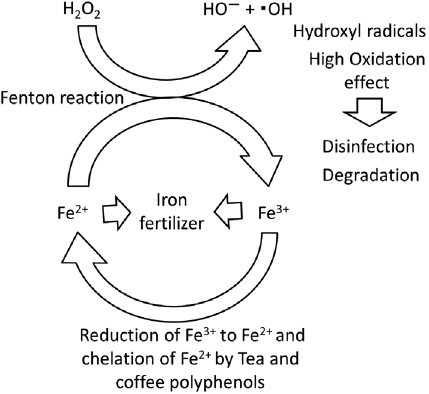
Figure 8 Estimated mechanism for disinfection and degradation processes using tea and coffee polyphenols and